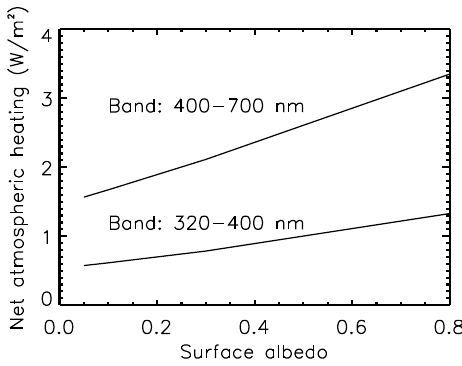
Fig. 2. NO 2 net atmospheric heating computed with the high spectral resolution (solid line) and the effective (dashed line) absorption coefficient.